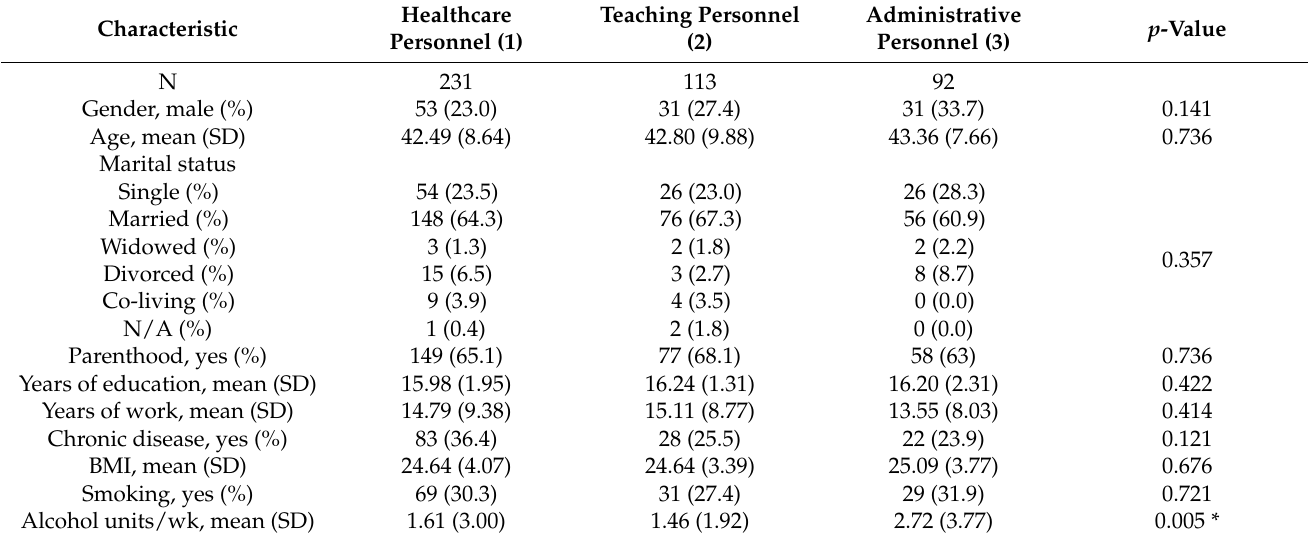
Table 1. Demographic and other characteristics of the participants by professional group.